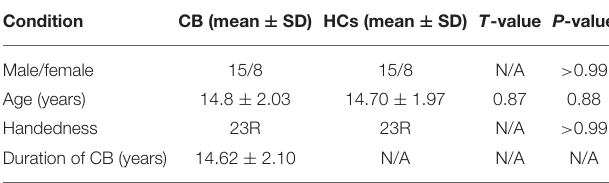
TABLE 2 | Clinical characteristics of participants in this